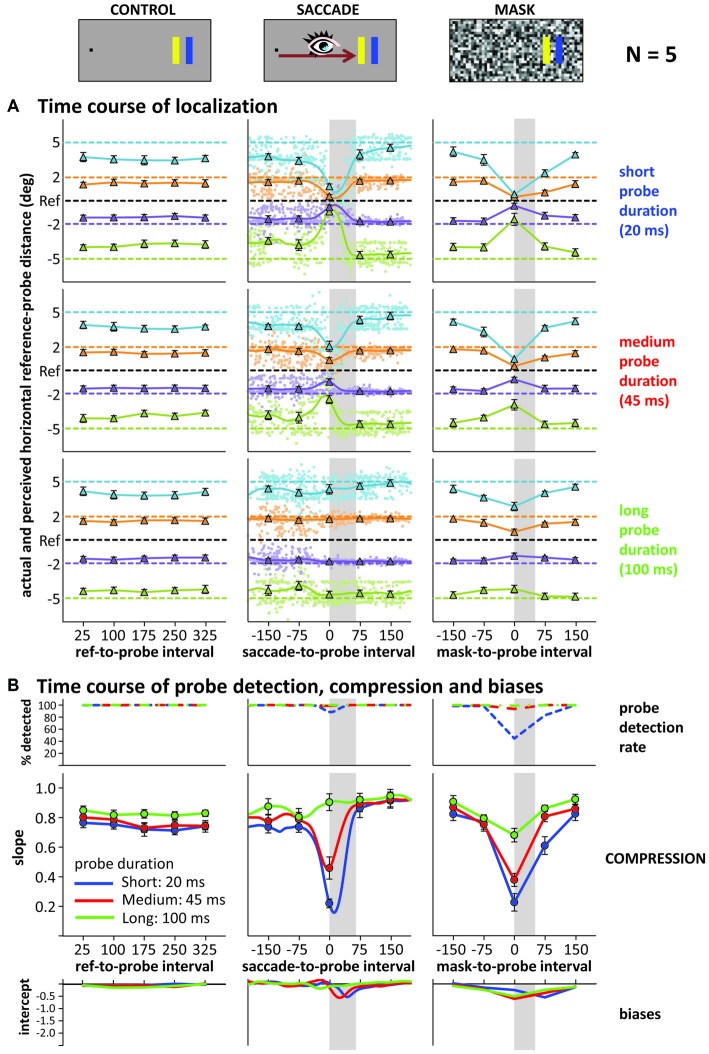
Results of Experiment 3. (A) Actual (horizontal dashed lines) vs. average reported (triangles and solid lines) reference-probe distance (control, saccade, mask) across time: reference-, saccade- or mask-to-probe interval (negative values: probe presented before saccade or mask; gray shaded areas illustrate the average saccade and mask duration). Depicted are data for short (upper), medium (middle) and long (lower) probe durations. Data is averaged across all five participants. Saccade graphs: small dots represent individual trial data, smooth curves the weighted running average. (B) Detection rates, compression indices (slopes) and biases (intercepts) across time and probe duration in control (left), saccade (middle; smooth curves: running averages, circles: time points as in control and mask conditions) and mask (right) condition. All error bars: standard error of the mean across participants.